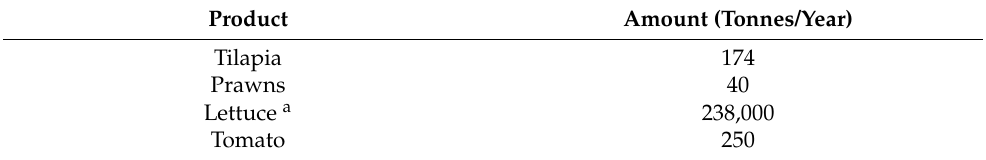
Table 1. The scale of PISCIS production [19].